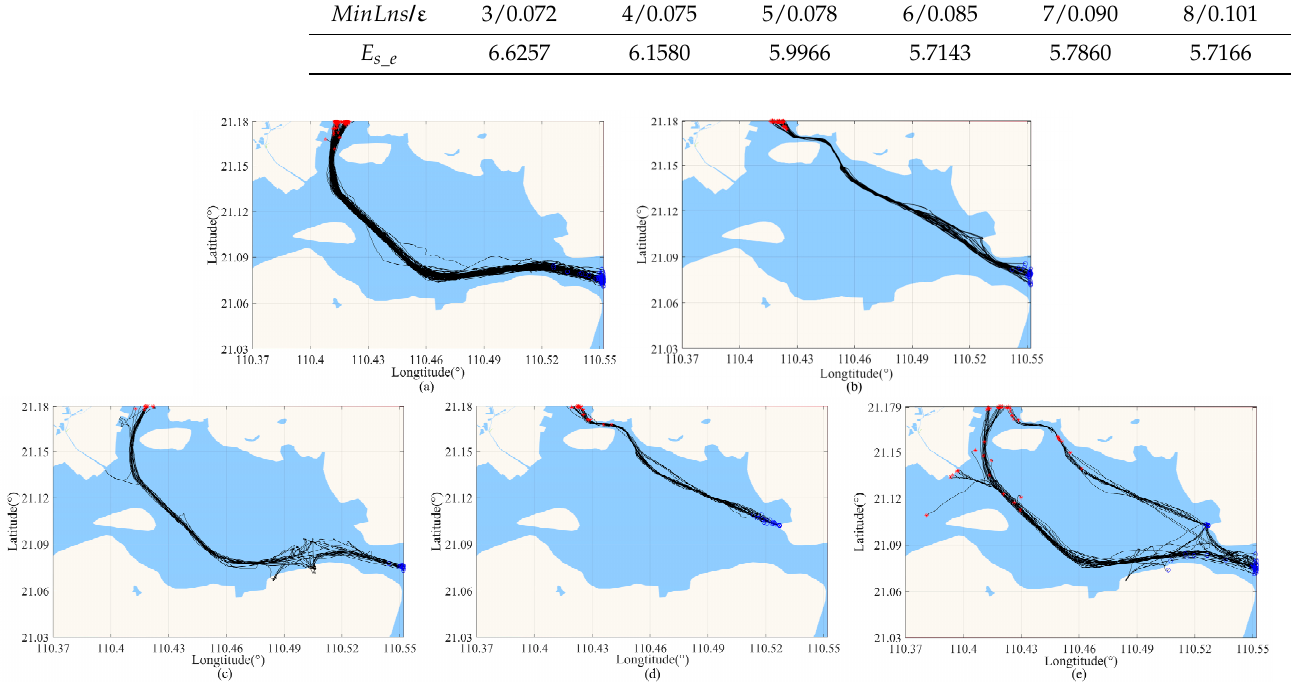
Figure 14. DBSCAN Clustering results of Figure 10a with MinLns = 6 and ε = 0.085. ( a ) Class A, 141; ( b ) Class B, 30; ( c ) Class C, 21; ( d ) Class D, 26 ( e ) abnormal trajectories, 49.